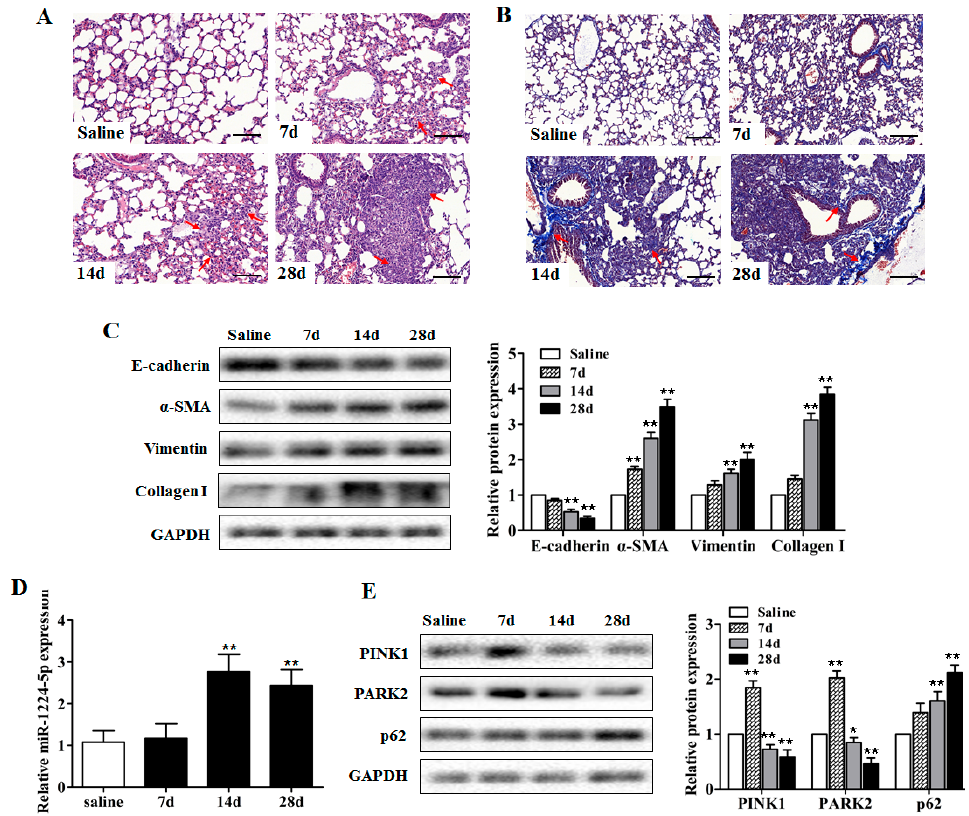
Figure 1. miR-1224-5p is increased and mitophagy is impaired in mouse lung tissues in a model of silica-induced pulmonary fibrosis. ( A ) The C57BL/6 mice were sacrificed on days 7, 14 and 28 after intratracheal instillation of silica suspended saline and saline. Histological changes of lung tissues were observed by haematoxylin and eosin (H&E) staining. Red arrows indicate the fibrotic nodules and damaged alveolar architecture. Scale bar: 100 µm; ( B ) Collagen deposition of lung tissues were observed by Masson’s trichrome staining. Red arrows indicate the collagen deposition. Scale bar: 100 µm; ( C ) Western blot and densitometric analysis of the protein expression of E-cadherin, α -SMA, Vimentin and Collagen I in mouse lung tissues, with ** p < 0.01 vs. the saline group; ( D ) qRT-PCR analysis of miR-1224-5p expression in mouse fibrotic lung tissue on days 7, 14 and 28 ( n = 6 for each group), U6 was used as an internal control, with ** p < 0.01 vs. the saline group; ( E ) Western blot and densitometric analysis of the protein expression of PINK1, PARK2, and p62 in mouse lung tissues, with * p < 0.05 and ** p < 0.01 vs. the saline group. All data are expressed as the mean ± SD of at least three independent experiments.